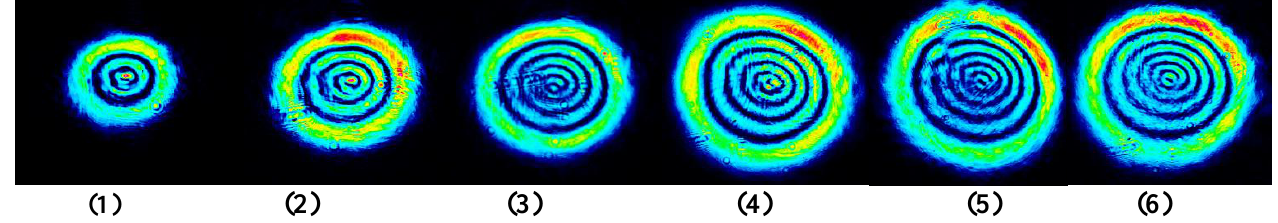
Fig.2: CCD camera photographs for the sample of the colloidal silver-nanoparticles in DI in the presence of TSC as a stabilizer with mean particle size of 50 nm show: The two –dimension image for the far-field diffraction ring patterns at different intensities: (1) 348, (2) 436, (3) 523, (4) 639, (5) 697 and (6) 784 W/cm 2 .